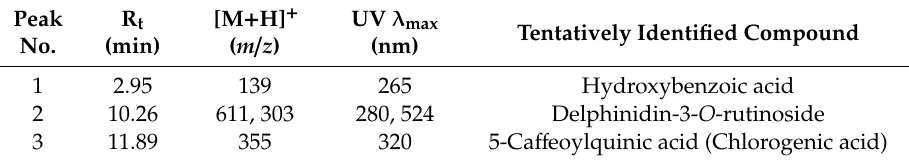
Table 5. Characterization of phenolic compounds in eggplant via positive LC-MS.